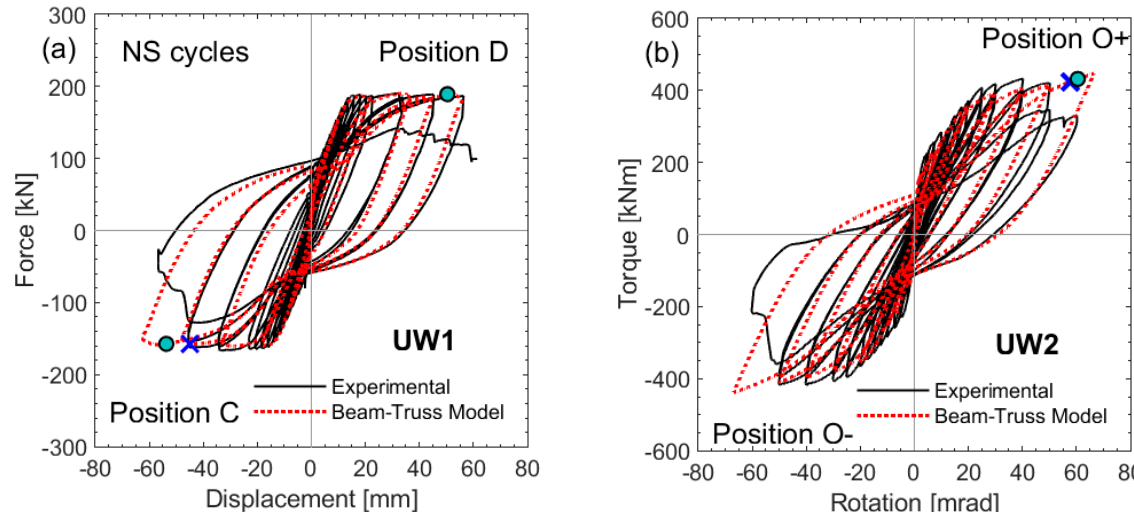
Figure 6. Beam-truss model results using SeismoStruct compared to the experimental results for ( a ) wall unit UW1 [22], north–south cycles, positions C–D and ( b ) wall unit UW2 [22], rotation cycles, positions O ± . The cross and circle markers indicate the numerically estimated concrete crushing and rebar buckling, respectively, corresponding to the defined strain limits.